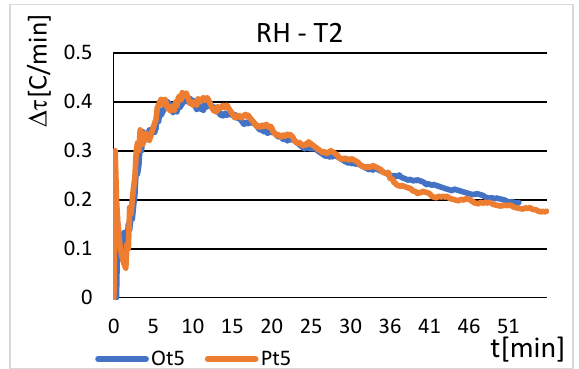
Figure 23. Dynamics of temperature increment across the stock-rail web (T2) in resistance heating RH for: Ot5—the switch-rail moved away from the stock-rail and the ambient temperature − 5 ◦ C; Pt5—switch-rail in contact with the stock-rail and the ambient temperature − 5 ◦ C.